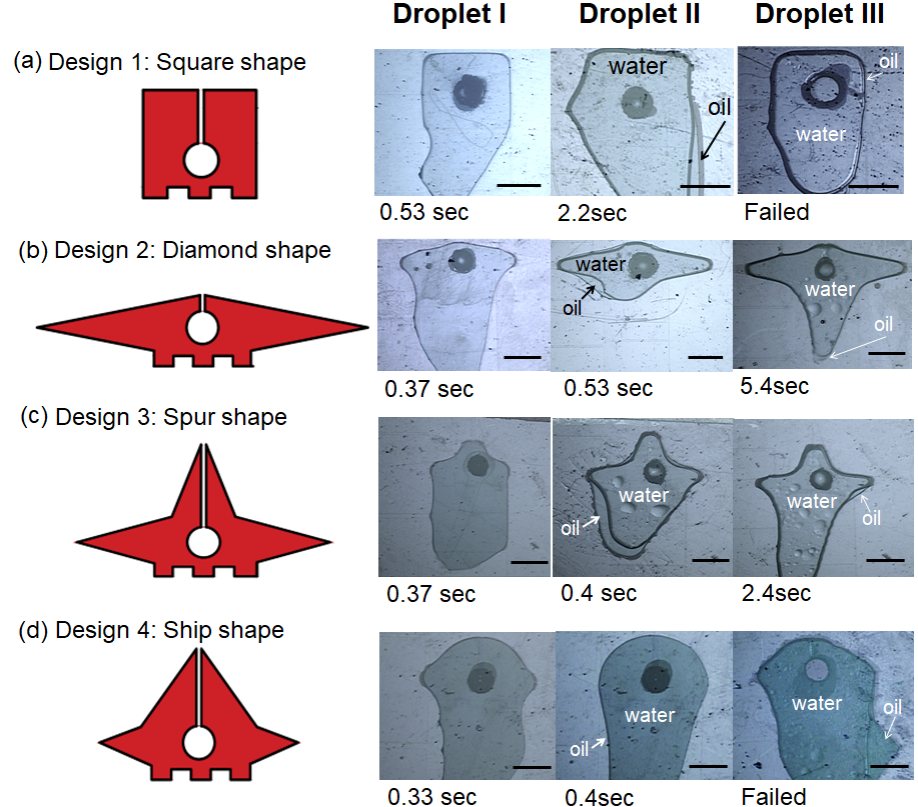
Figure 4. Droplets on the terminal electrodes of four designs moving from the initial to suspended stages (scale bar = 1mm).